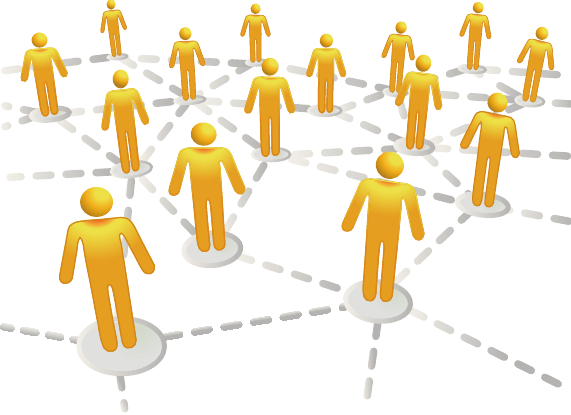
Figure 1: An example of large-scale multiagent